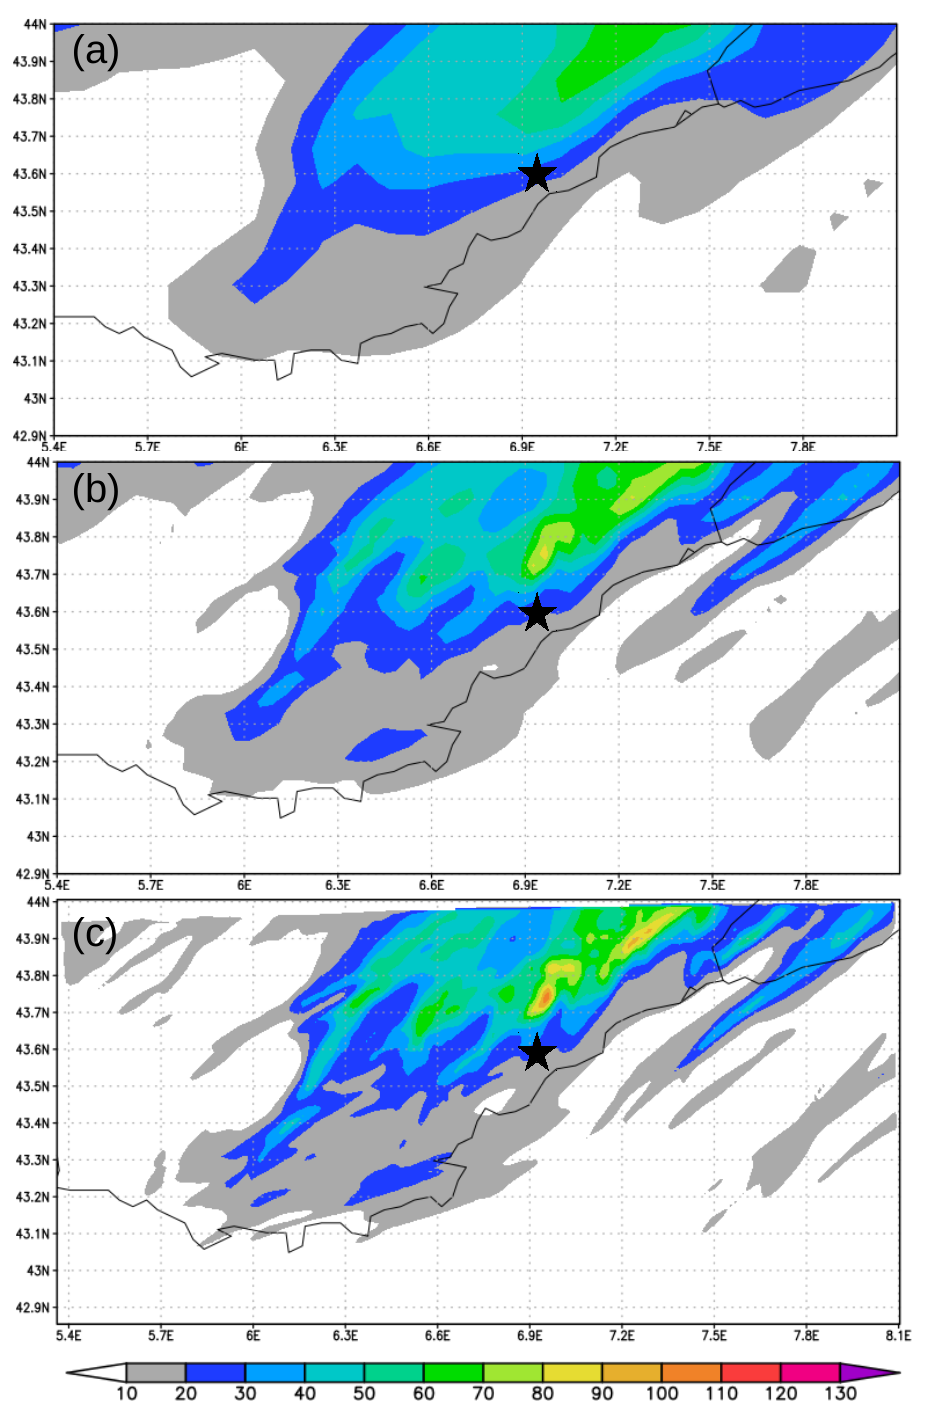
Figure 7. Cumulated precipitation (mm) over 6 h predicted over Provence-Alpes-Côte d’Azur area by the WRF model at different resolutions: 10 km , ( a ), 3.3 km, ( b ), and 1.1 km, ( c ). Simulations are initialized at 00 UTC of 3 October 2015 using GFS fields and the accumulation period is 17 UTC–23 UTC. Black star identifies observed precipitation peak